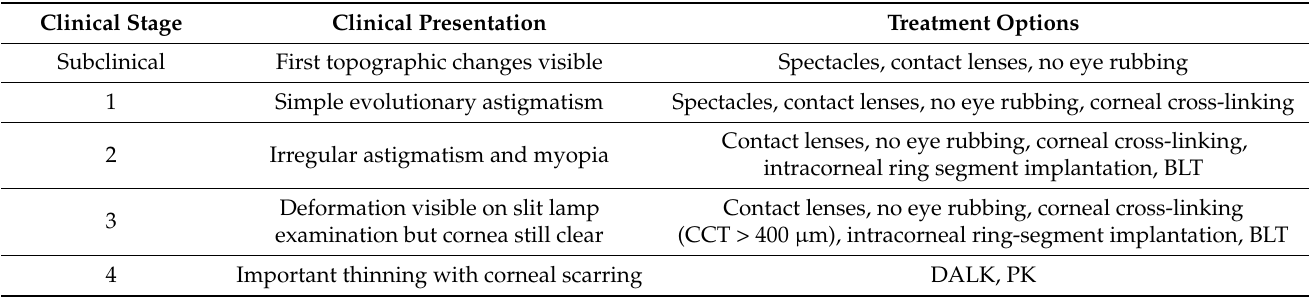
Table 1. Treatment options.